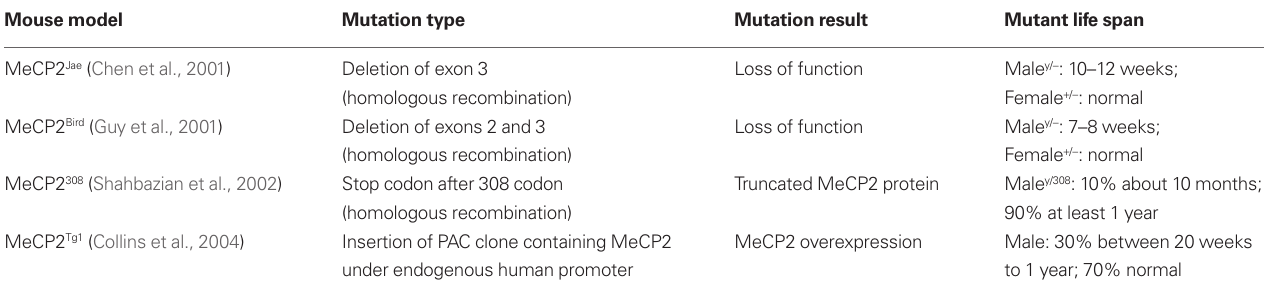
Table 1 | Types of MeCP2 mouse mutants tested for defects in synaptic connectivity and plasticity. Mouse